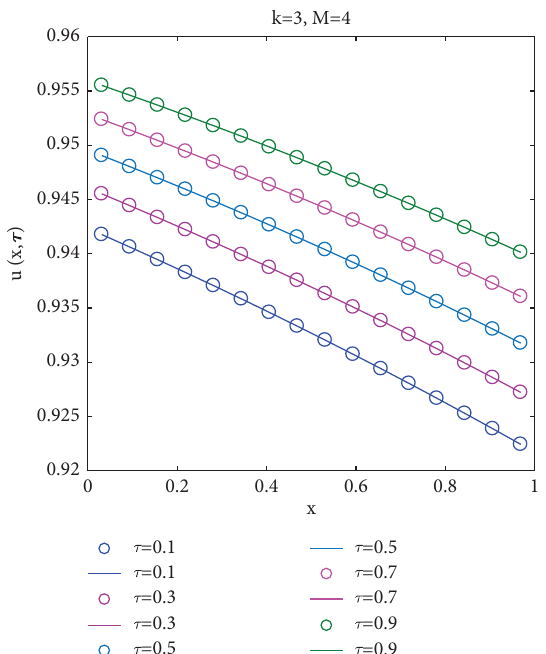
Figure 4: Approximate and exact solution for diferent τ of Example 2.